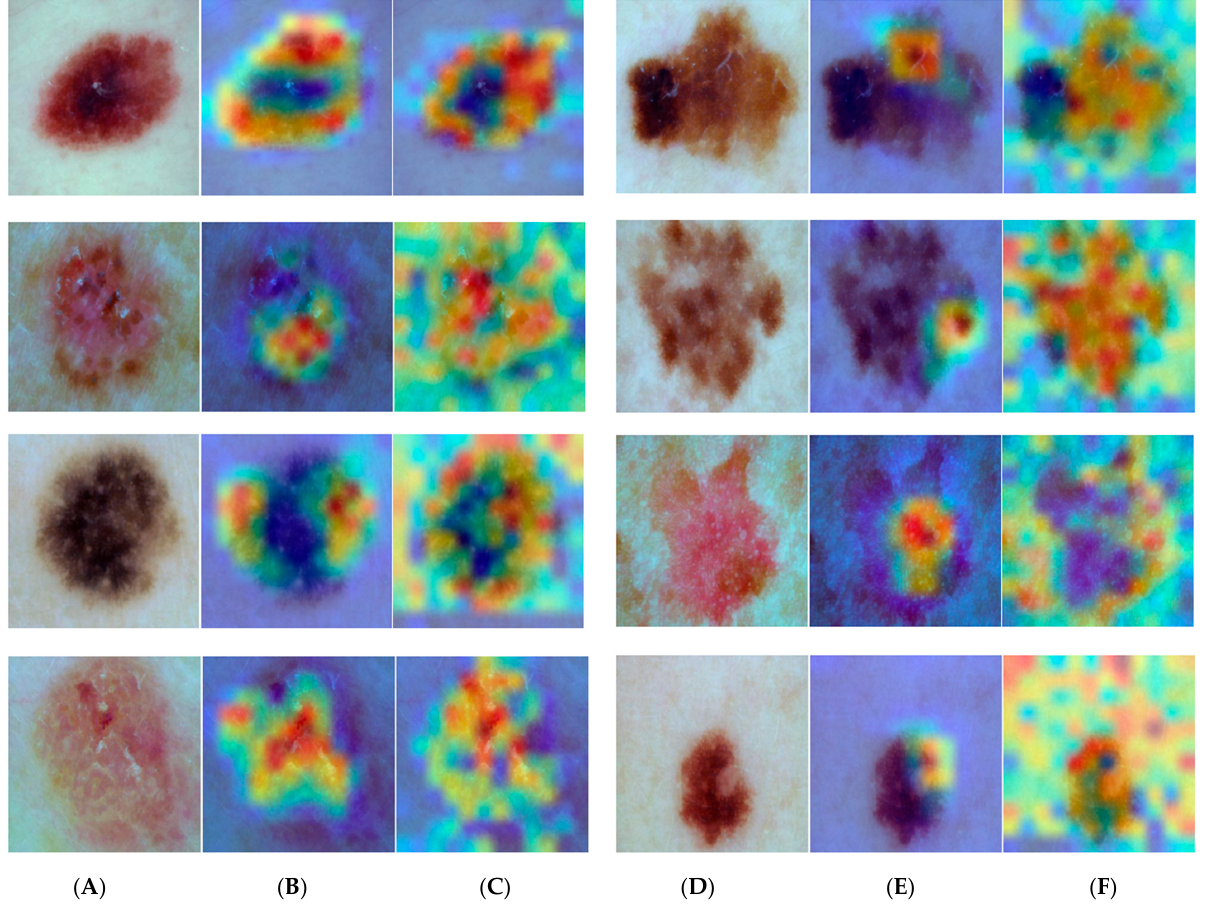
Figure 10. ( A – D ) are the real images ( B – E ) visualization of our baseline EfficientNetV2S model ( C – F ) visualization of our ensemble model (EficientNetV2S + Swin-Transformer model).